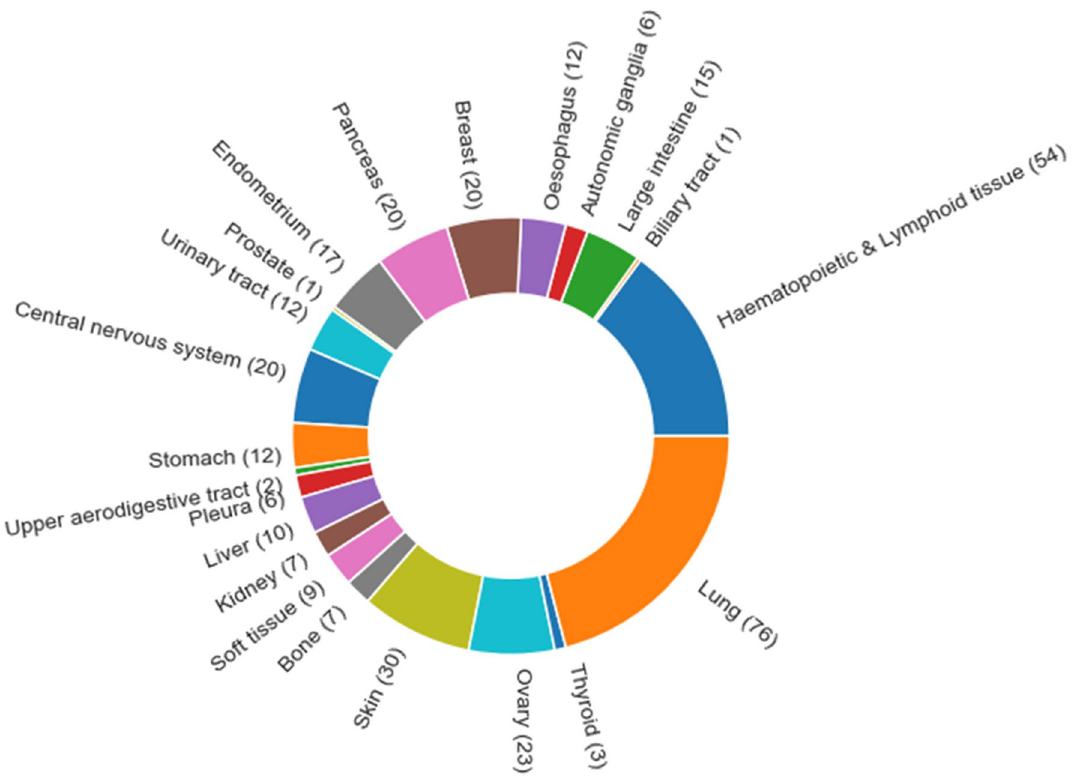
Figure 4. Tissue types in CCLE. The number of cell lines in each tissue type is shown in parenthesis.